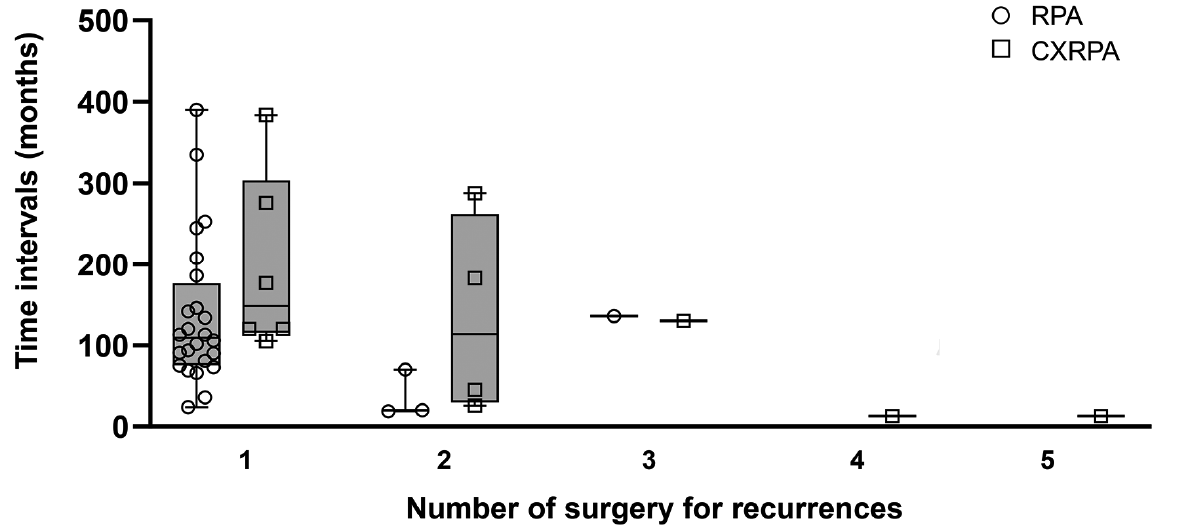
Figure 2. Recurrence intervals according to the number of recurrences (surgery) in recurrent pleomor- phic adenoma and carcinoma ex recurrent pleomorphic adenoma. Recurrence intervals according to the number of recurrence were not significantly different between RPA and CXRPA. RPA,